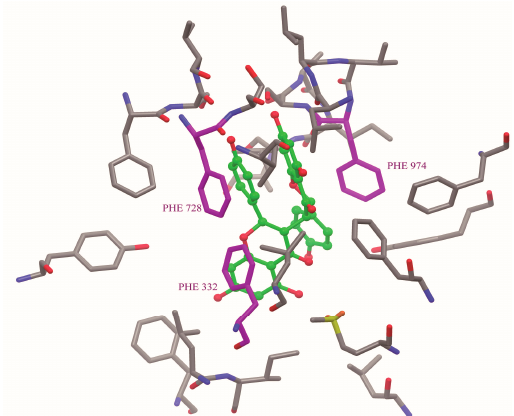
Figure 7. The structure of P-gp (green) and a pocket snapshot of NCB (cyan and white) from the molecular docking model.